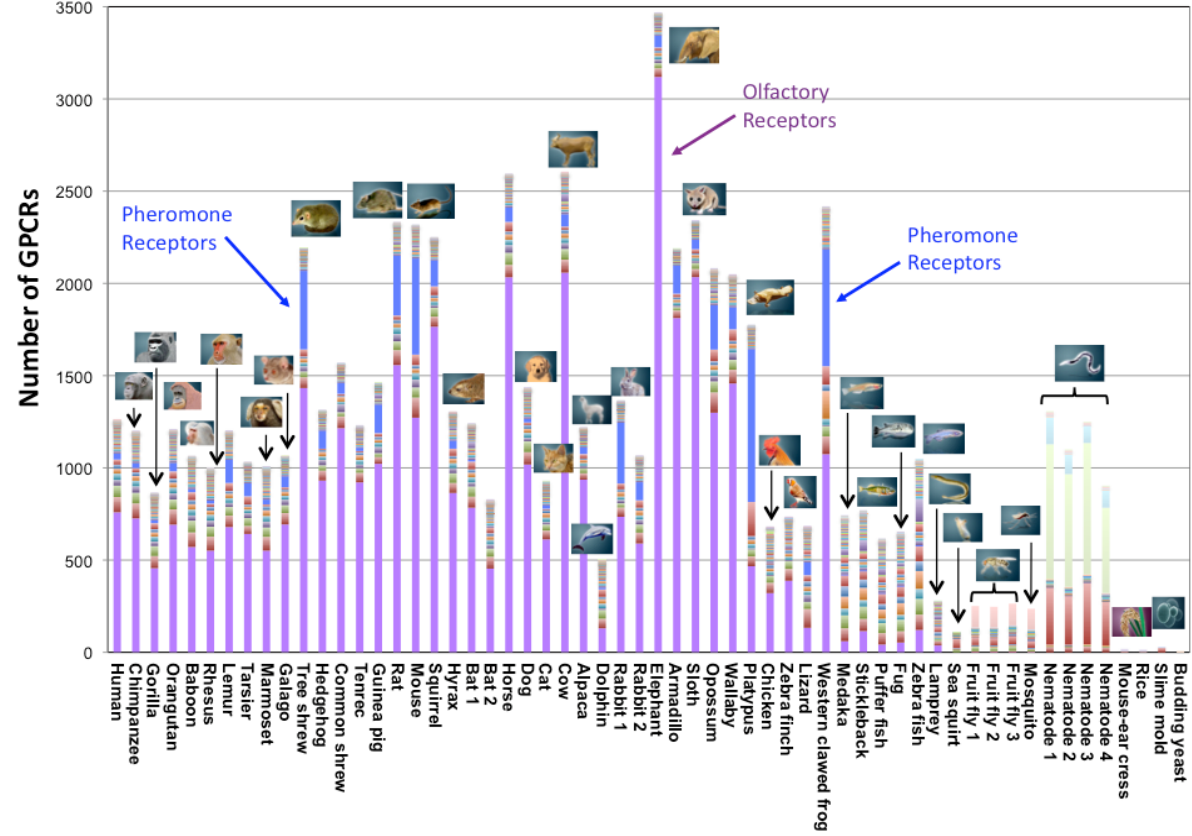
Figure 2. Number of GPCRs in 58 eukaryotes. Data from 56 eukaryotes (except sloth and horse) are deposited in SEVENS database. Each bar represents the total number of GPCRs with subfamily information indicated by different colors. Olfactory and pheromone receptors of vertebrates are in purple and blue, respectively. The specific names of members in four species are as follows. Bat1: Pteropus vampyrus ; Bat2: Myotis lucifugus ; Rabbit1: Oryctolagus cuniculus ; Rabbit2: O. princeps ; Fruit fly1: Drosophila melanogaster ; Fruit fly 2: D. simulans ; Fruit fly 3: D. yakuba ; Nematode 1: Caenonhabditis elegans